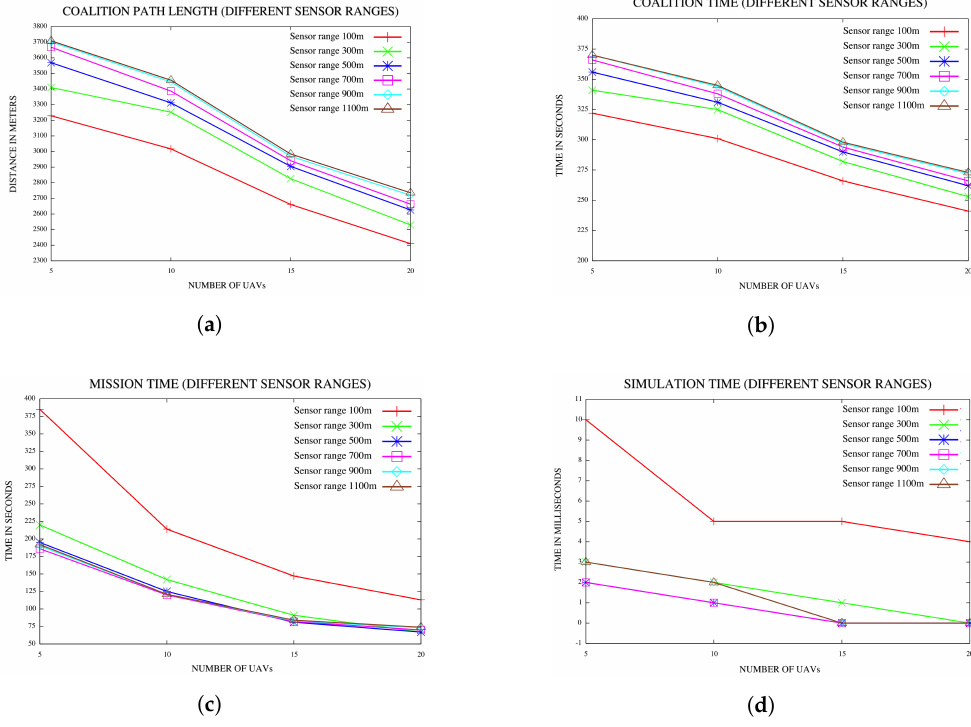
Figure 11. ( a ) Coalition path lengths for various sensor ranges; ( b ) coalition times for various sensor ranges; ( c ) mission time for various sensor ranges; ( d ) simulation time for various sensor